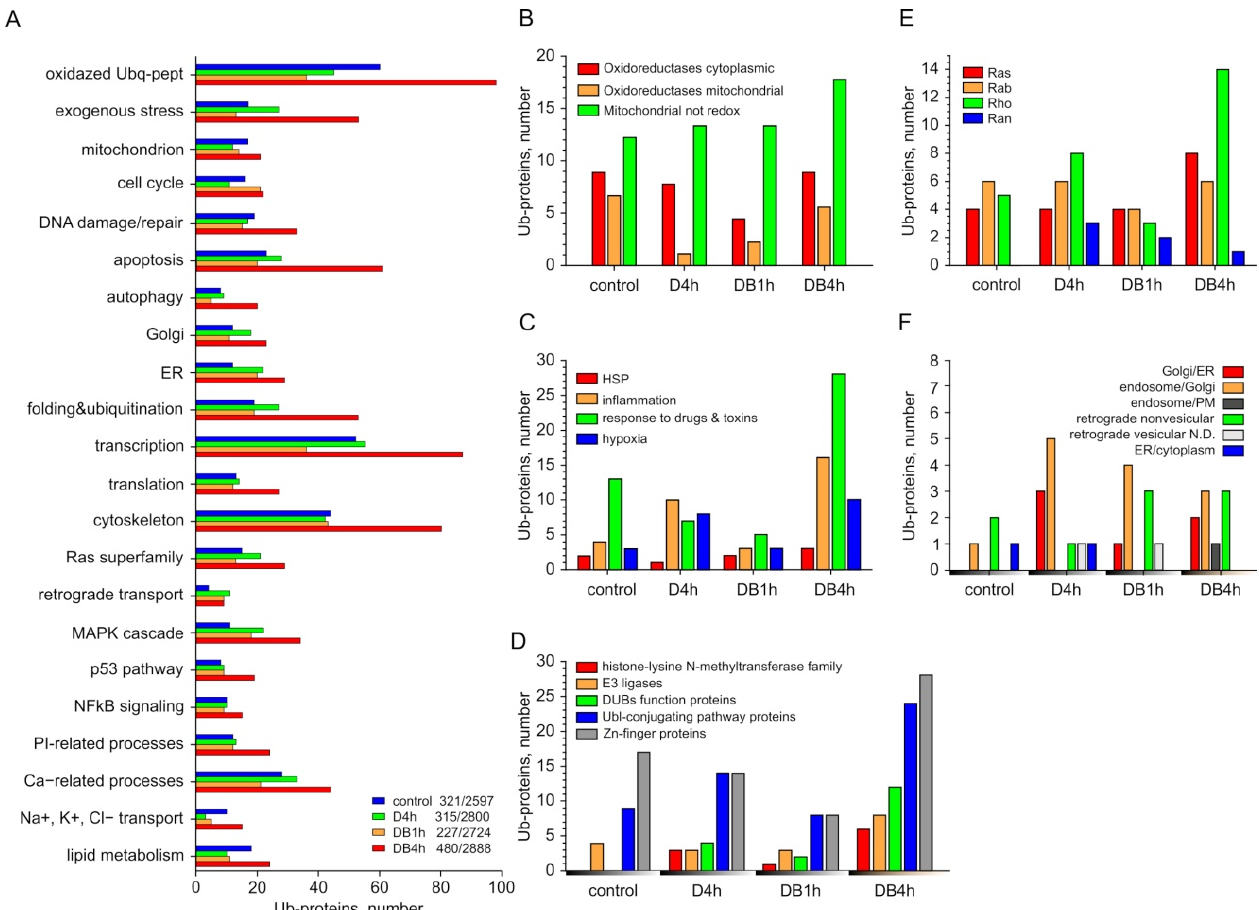
Figure 3. The numbers of Ub-proteins found in DB4h, DB1h, D4h, and control samples in different UniProtKB groups. ( A ) General analysis by groups. The number of all Ub-proteins versus the total number of proteins detected in the samples is indicated. ( B ) The increase in the numbers of cytoplasmic and mitochondrial Ub-oxidoreductases and mitochondrial non-redox Ub-proteins. ( C ) The numbers of Ub-proteins of some intracellular systems that respond to exogenous stress; ( D ) histone-lysine N-methyltransferase family, E3 ligases, DUBs’ function proteins, Ubl-conjugating pathway proteins, and zinc finger proteins. ( E ) Ras superfamily and ( F ) retrograde